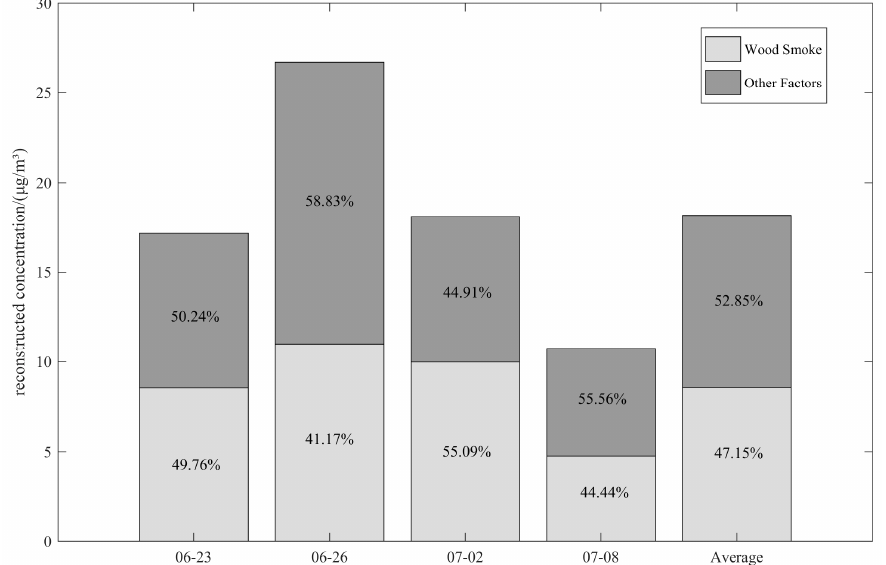
Figure 9. Percentage of wood smoke factor accounted for reconstructed PM 2.5 on violation days during the Aggie Creek Fire.